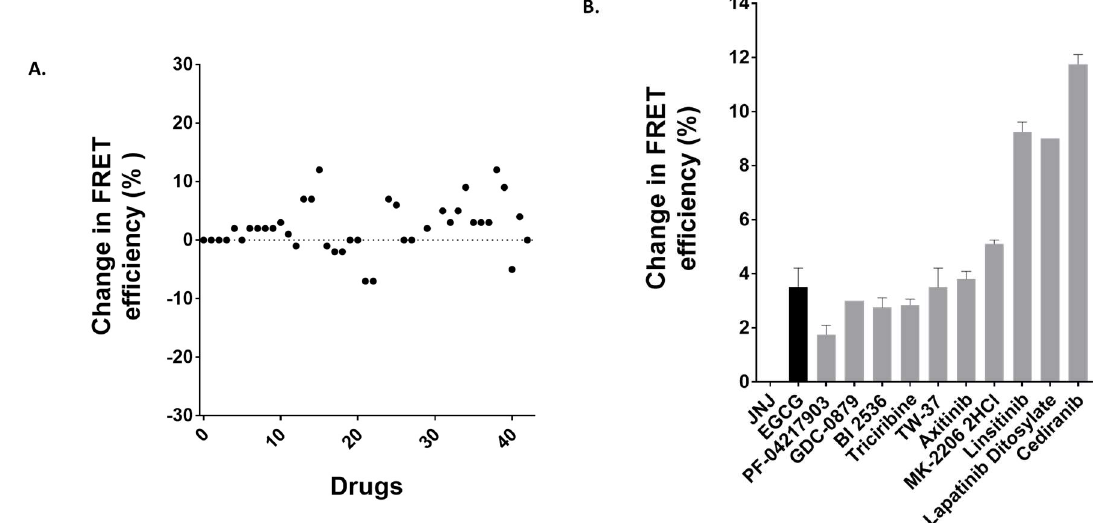
Figure 7. Anti-cancer drug screening with two-color GR-881. ( A ) Change in FRET efficiency (%) for the 40 anti-cancer drugs from one trial. ( B ) Ten anti-cancer compound hits which increased FRET and produced high and consistent FRET changes in three independent screening experiments using two different membrane vesicle batches. FRET measurements were performed using Fluorimeter model FL3-11. Donor was excited at 465 nm, and emission was collected within the 480–650 nm range and donor quenching was observed. Data are represented as means ± standard error of the mean (SEM) from three independent experiments. Anti-cancer drug JNJ 38877605 is included as a negative control.